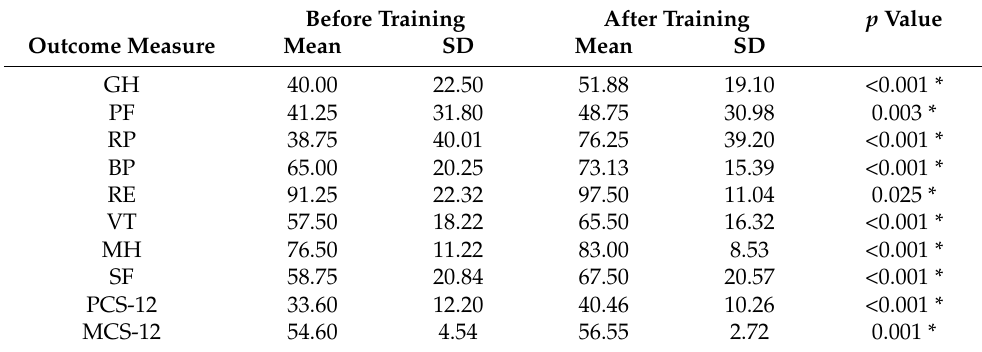
Table 1. SF-12 survey before and after 4 weeks cycling wheelchair